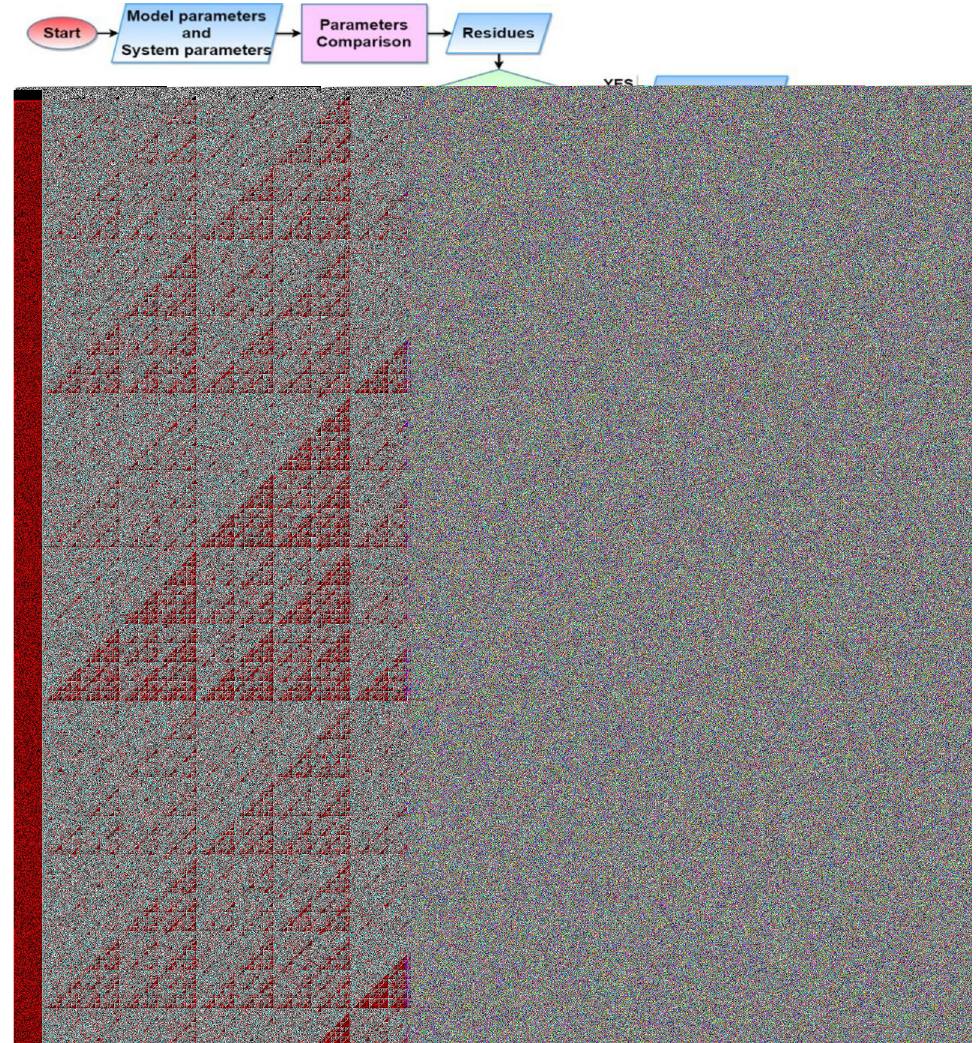
Fig 12. A diagnostic algorithm based on the electrical signatures obtained from the six derived parameters for monitoring the P.V.